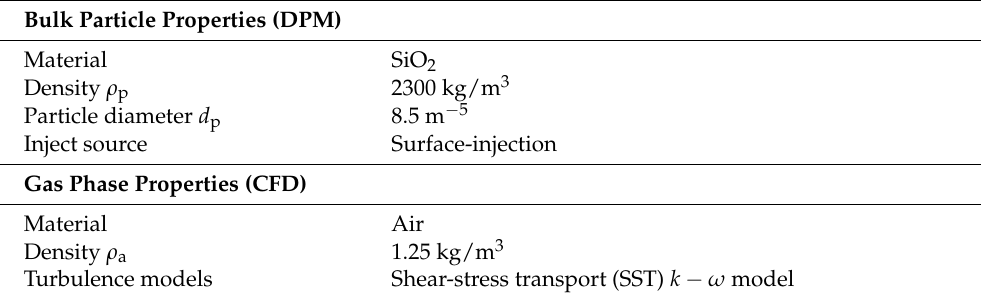
Table 1. Simulation of general setups.